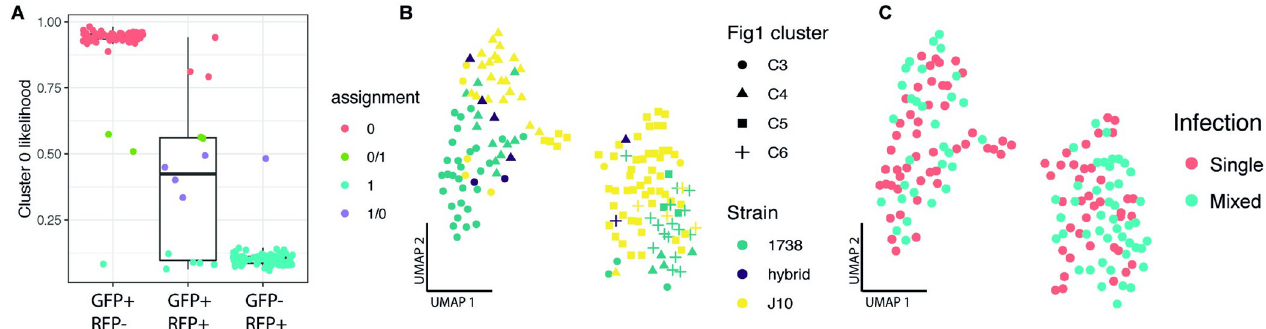
Fig 4. Classification of hybrid progeny. Souporcell was used to assign genotypes based on SNPs found between the two strains. The two genotype assignments (0,1) were each primarily composed of one of the strains based on fluorescent identification with FACS (strain 1738 GFP+/RFP- = cluster 0; strain J10 GFP-/ RFP+ = 1), and the potential hybrid progeny were classified as inter-genotypic doublets (clusters 0/1 and 1/0). The likelihood ratio of cluster 0 assignment is shown for each of the three sorted populations (A). The UMAP of day 24 mixed- and single-infection experiments coloured by strain assignment and shaped by Fig 1 cell cluster assignment (B) and infection treatment